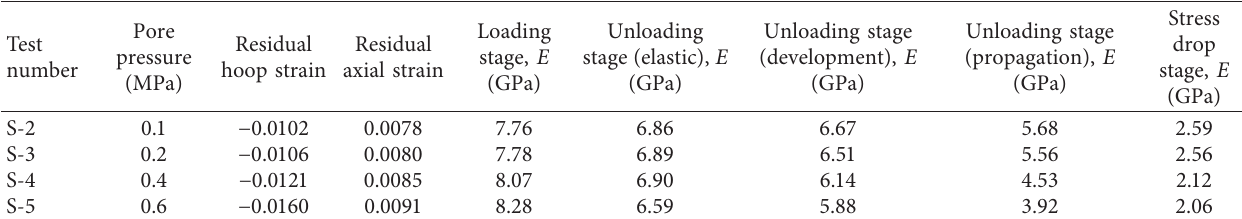
Table 2: Characteristic parameter values during unloading seepage